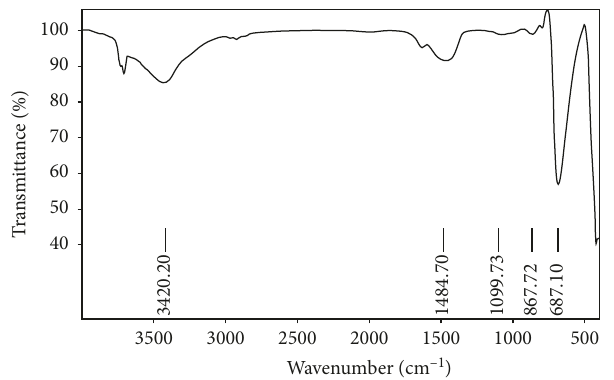
Figure 2: FTIR spectra of magnesium oxide